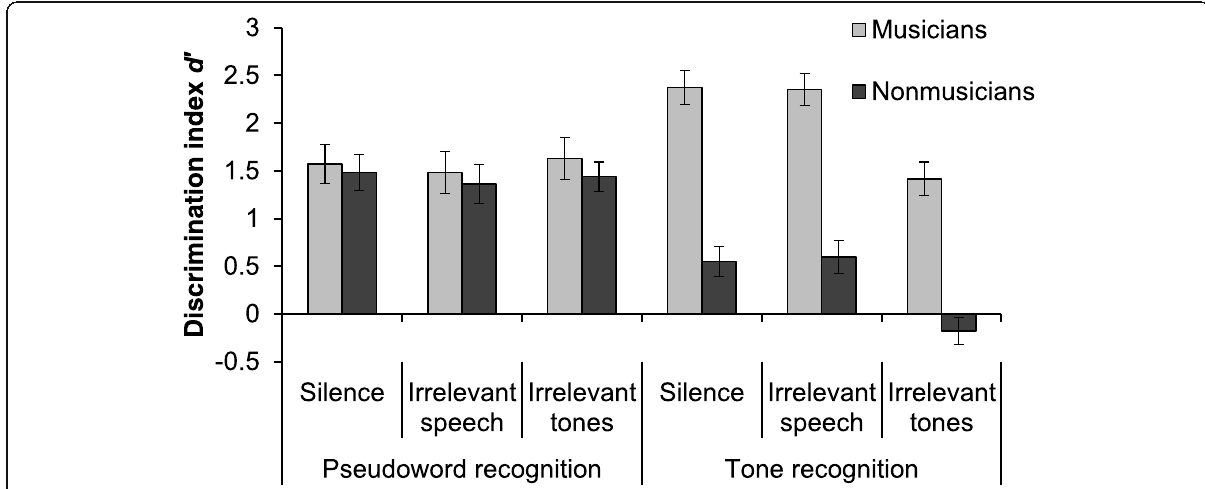
Fig. 1 Mean proportion of correct responses in pseudoword and tone recognition by musicians and nonmusicians in silence or in presence of irrelevant speech or tones. Error bars denote standard errors of the